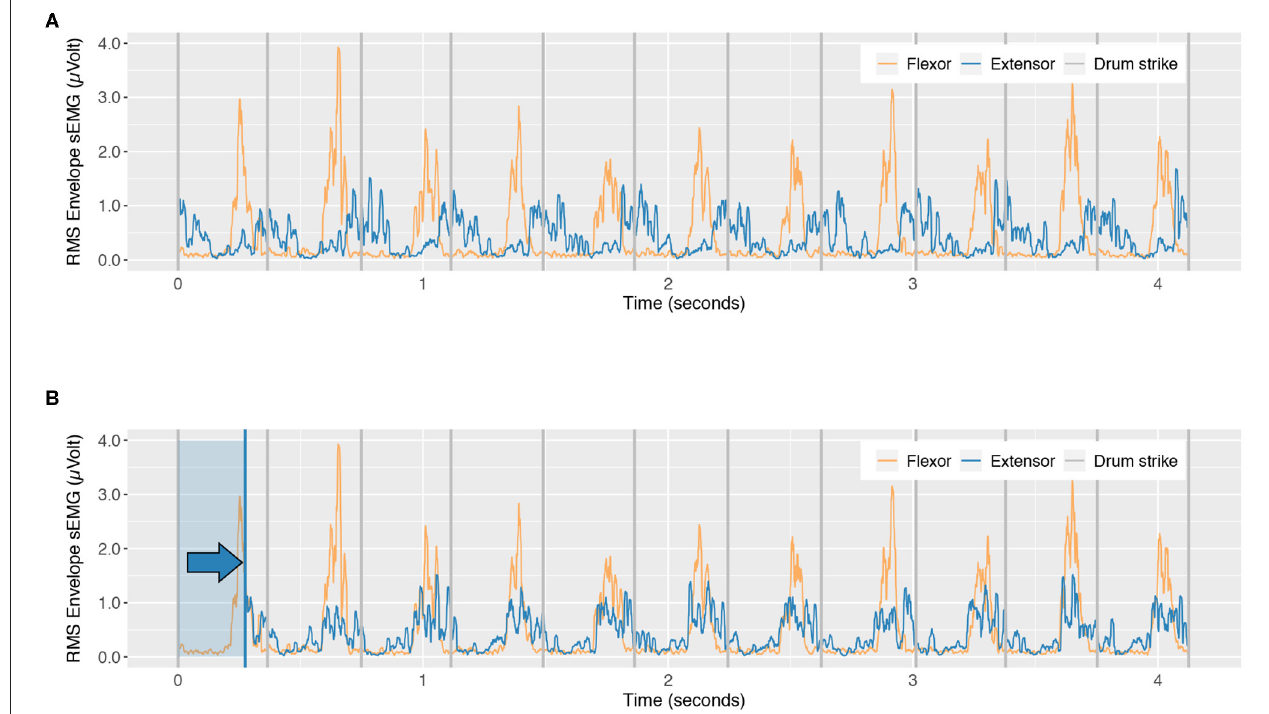
FIGURE 5 | Marginal effects plot of sdRDS and tempo on the predicted probability that an observation derives from an expert drummer. Line color indicates tempo. The 240 HPM tempo is at the top of the legend, as it represents the model’s baseline. The model attributes higher sdRDS to drumming expertise. This is particularly visible at 80 HPM (blue line), which shows the steepest slope. Bands represent 95% CIs.